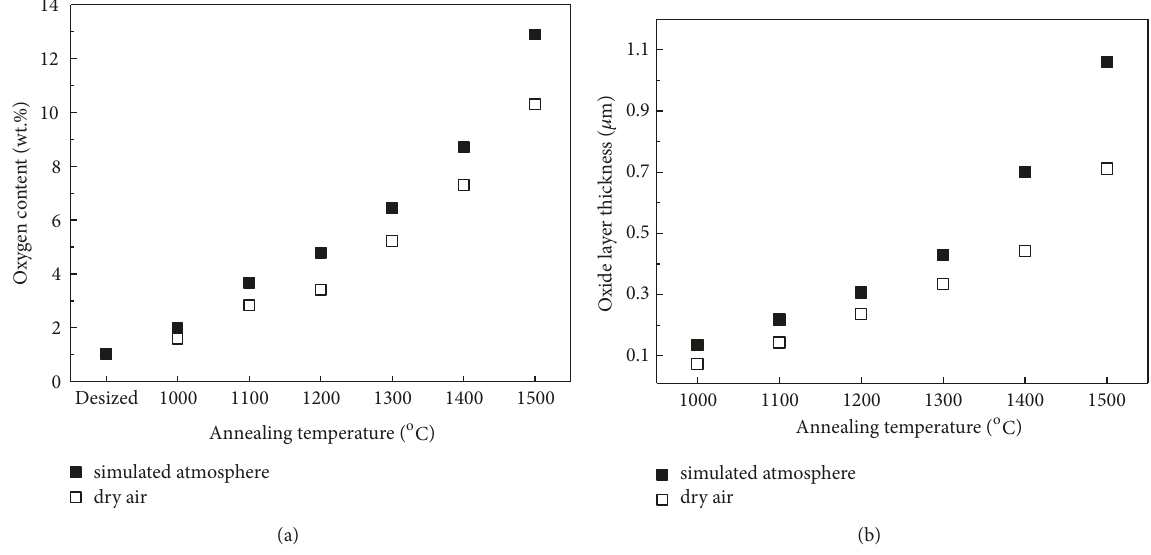
Figure 2: The oxygen content and oxide layer thickness of KD-S fibres after annealing at 1000-1500 ∘ C for 1 h. (a) Oxygen content and (b) oxide layer